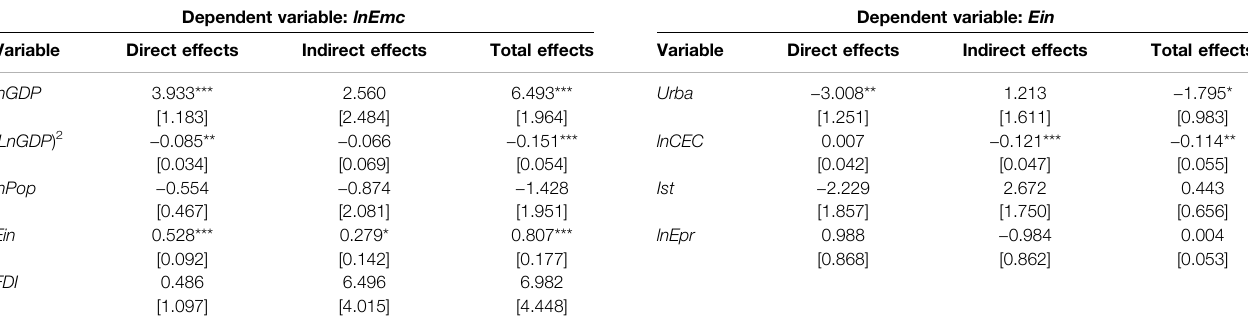
TABLE 7 | Direct, indirect, and total effects of the SDM models.